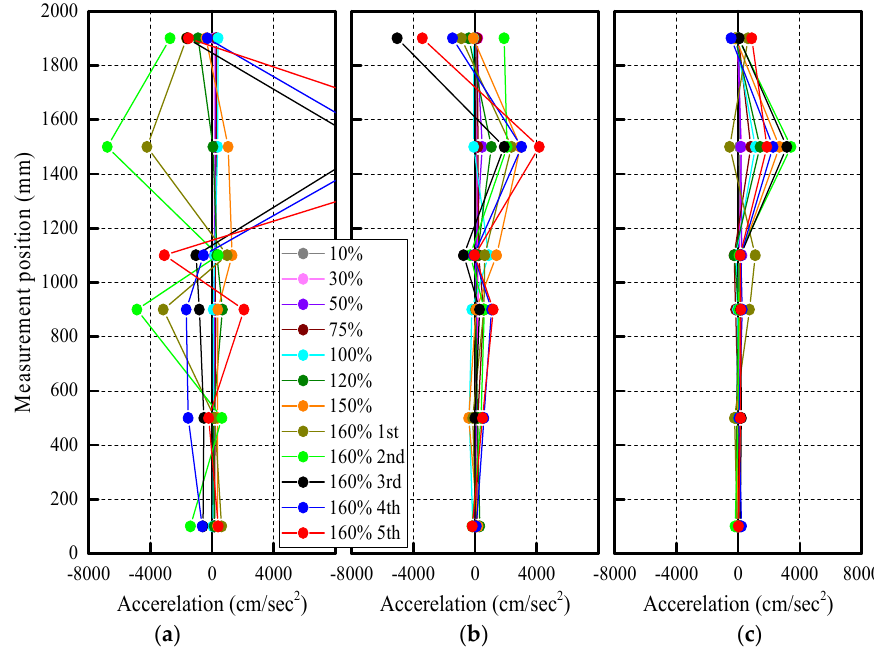
Figure 16. Acceleration profiles: ( a ) Specimen CB; ( b ) Specimen HS; ( c ) Specimen PS.